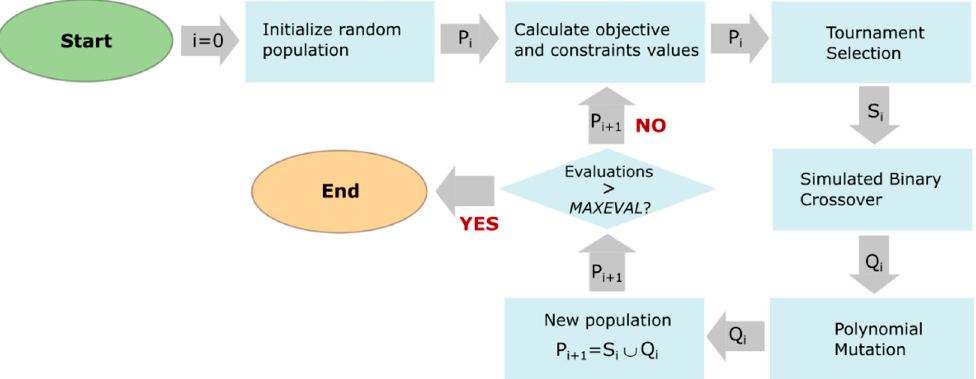
Figure 1. Flowchart of the genetic algorithm with elitism.